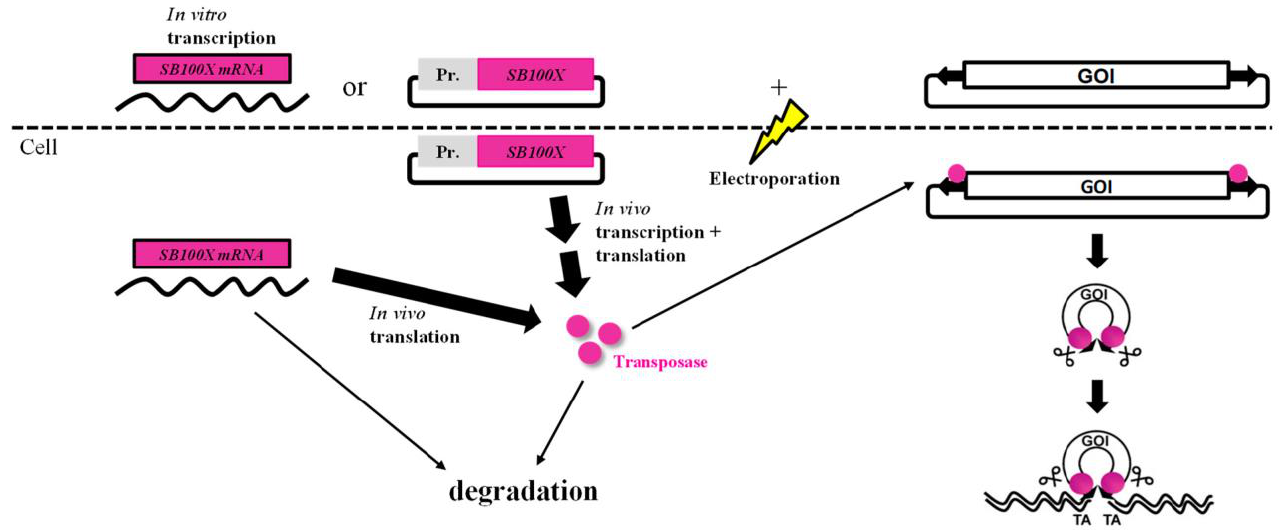
Figure 1. Non-viral Sleeping Beauty Transposon System. The transposon plasmid encoding the gene of interest and the SB100X transposase, delivered as DNA or mRNA, are introduced into the cells via electroporation. The transposase binds the TIRs flanking the GOI, cuts it out, and inserts it into the host cells’ genome to allow for stable and long-term expression and secretion of the therapeutic protein, such as PEDF.